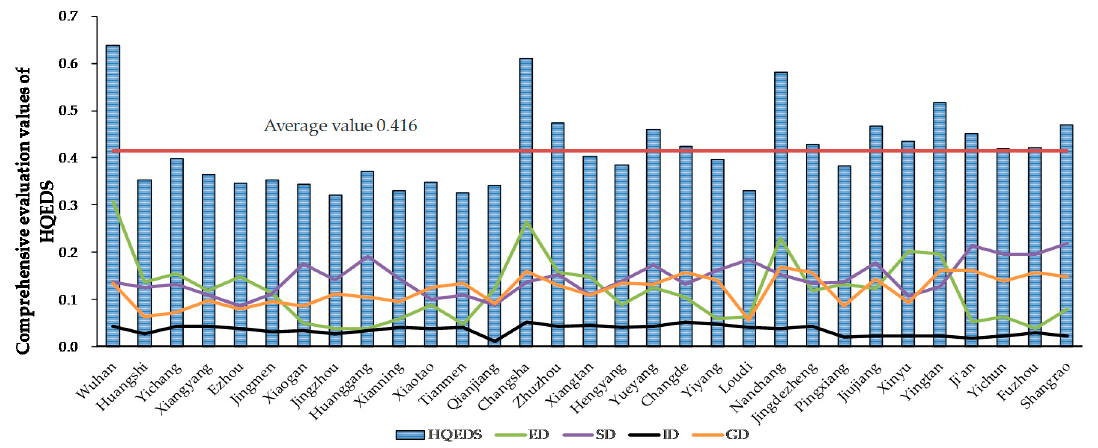
Figure 5. Average comprehensive evaluation values of the HQEDS from 2008 to 2017.